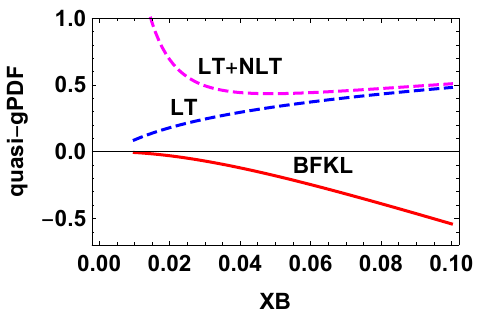
the LT (blue dashed curve), and LT + NLT (magenta dashed curve) contributions. The behavior